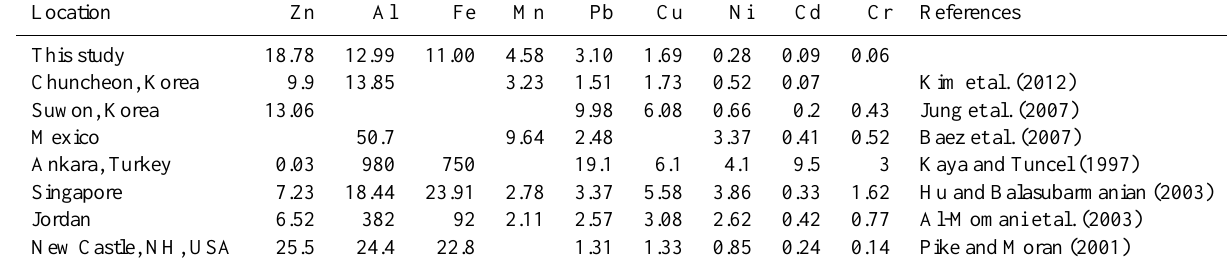
Table 5. Comparison between the VWMC of trace metals in precipitation in Gwangju and at other locations. Location